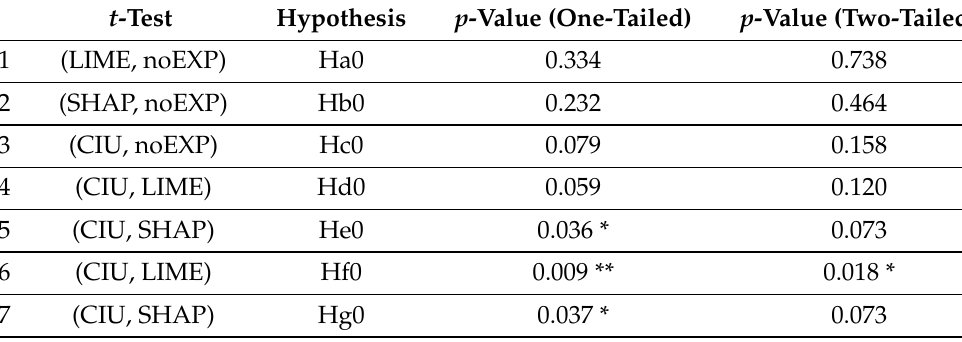
Table 10. Hypothesis analyses (note: * p < 0.05, ** p < 0.01) .